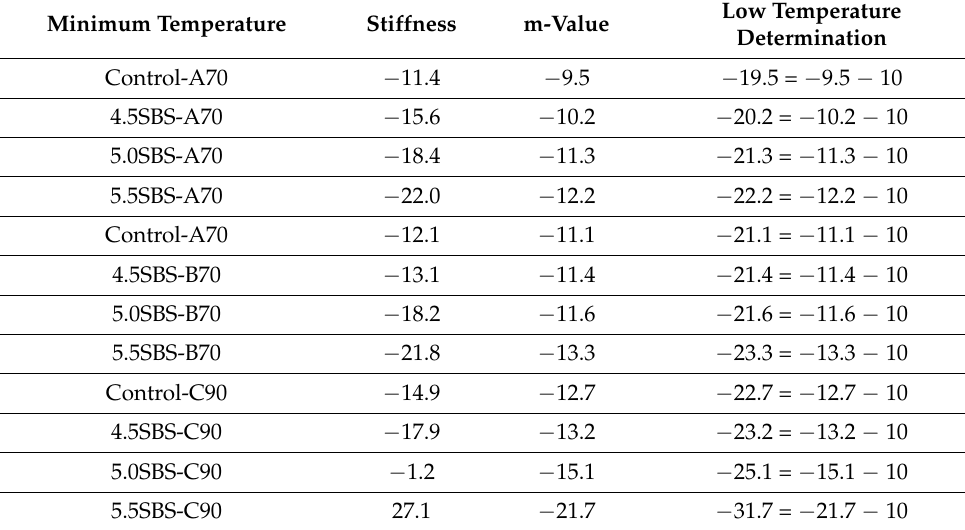
Table 3. Minimum low temperature determination results of SBS